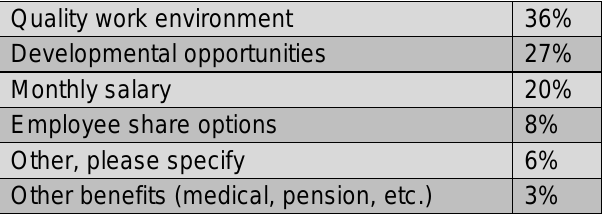
Table 4: Factors that Encourage Respondents to Remain with Current Employers Quality work environment 36% Developmental opportunities 27% Monthly salary 20% Employee share options 8% Other, please specify 6% Other benefits (medical, pension, etc.) 3%